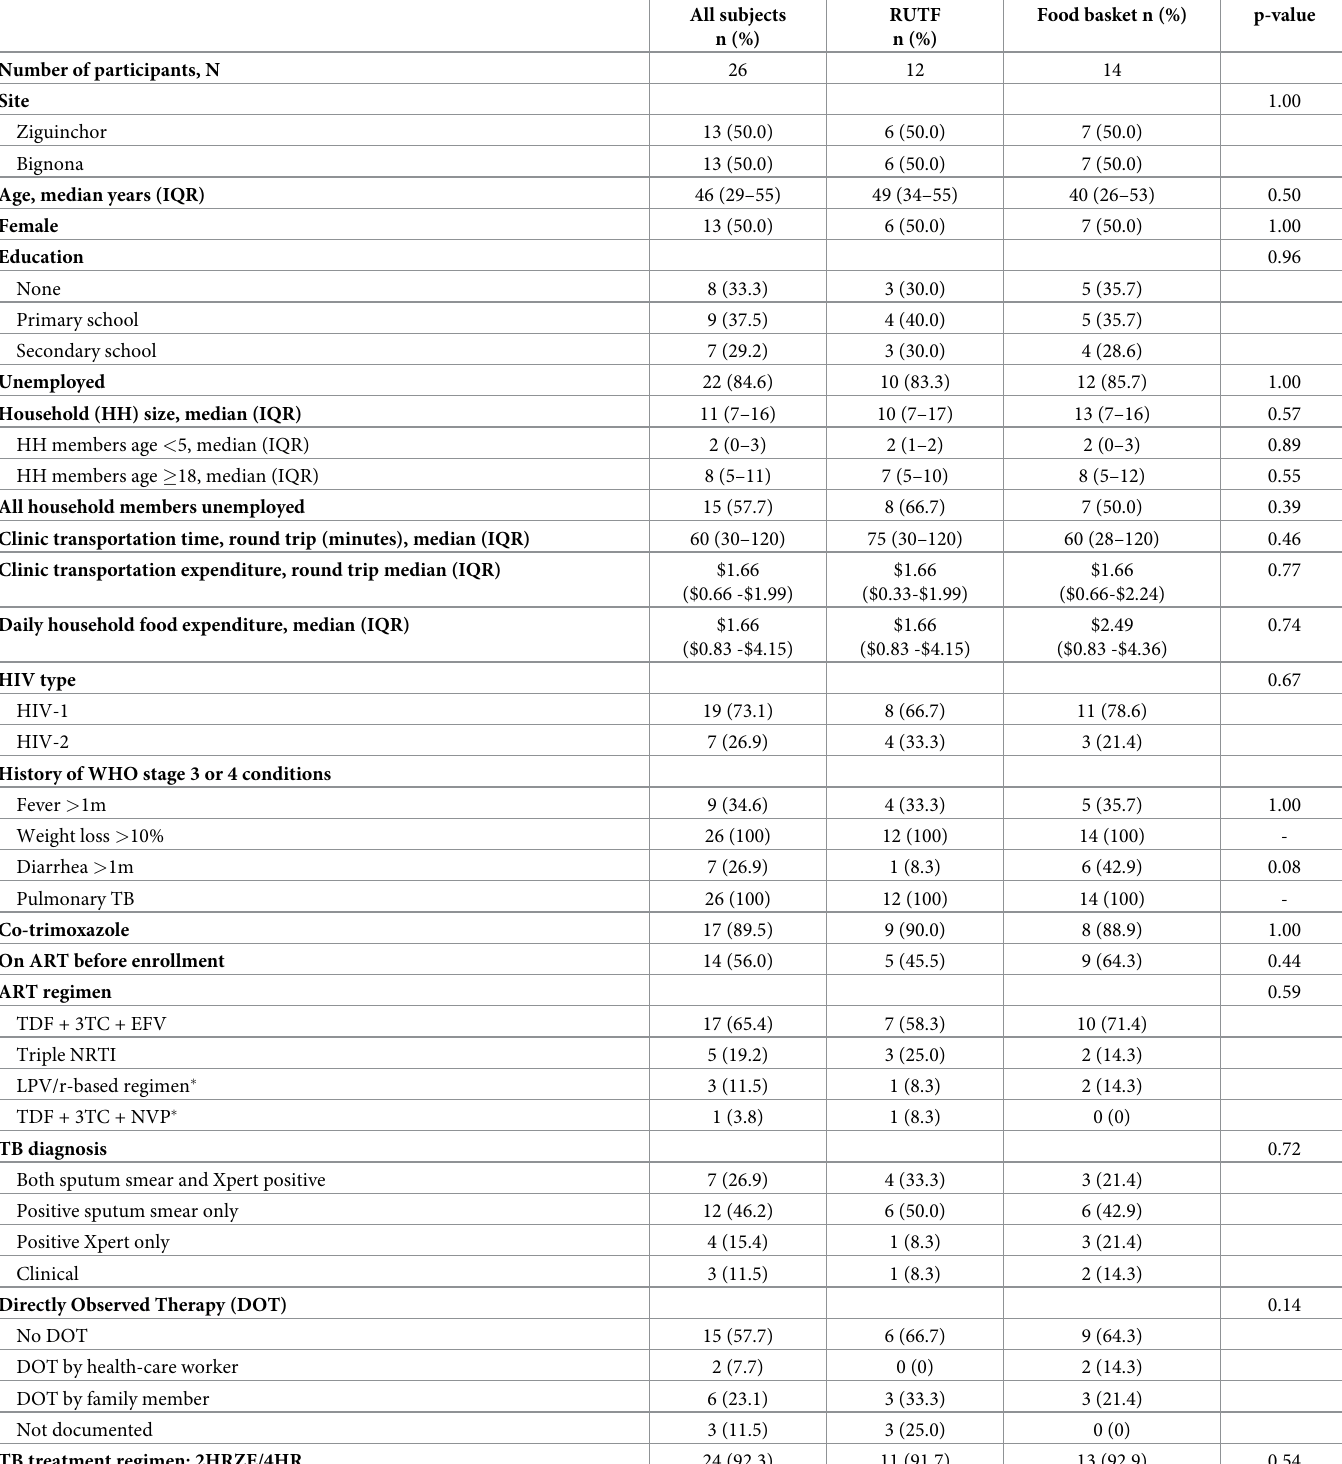
Table 1. Baseline characteristics of study participants in Ziguinchor and Bignona, Senegal,